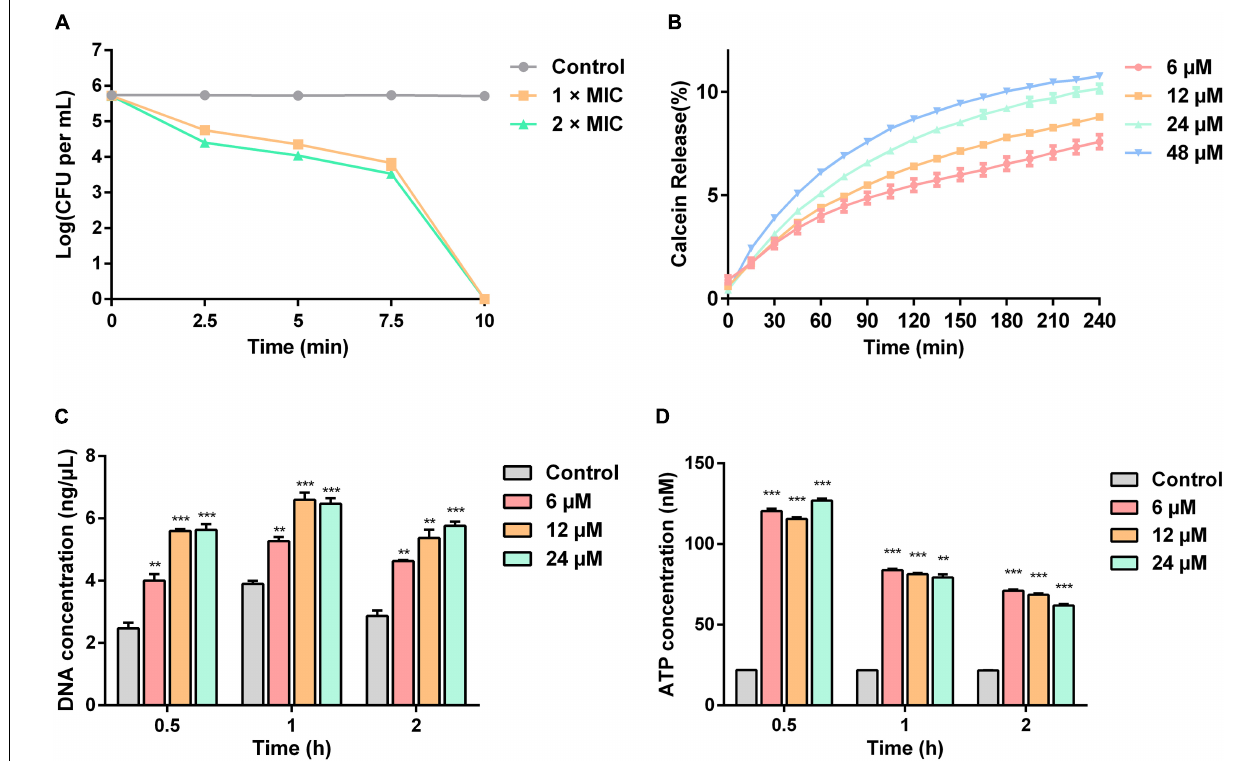
FIGURE 5 | Sparamosin 26 - 54 kills C . neoformans via disrupting the integrity of cell membranes. (A) The time-killing curves of Sparamosin 26 - 54 against C. neoformans . (B) The time course of calcein release from C. neoformans induced by Sparamosin 26 - 54 . (C) The concentration of extracellular DNA in C. neoformans after Sparamosin 26 - 54 treatment. The amount of extracellular DNA in the supernatants was quantified by spectrophotometry at 260 nm. (D) The concentration of extracellular ATP in C. neoformans after Sparamosin 26 - 54 treatment. The amount of extracellular ATP was detected using the ATP determination kit. Data represent mean ± standard error of mean from three independent biological replicates. Significant difference between control group and Sparamosin 26 - 54 treatment group was indicated by asterisks as ** p < 0.01; *** p <